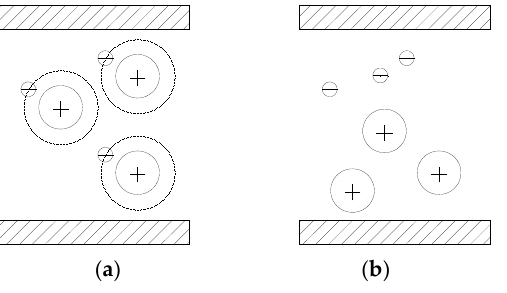
Figure 2. Ionization of atoms under the influence of the field. ( a ) No ionization at low intensity fields; ( b ) ionization in the area of high intensity.